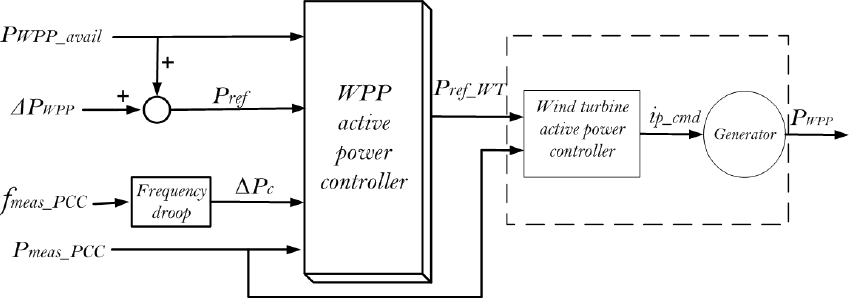
Figure 4. Aggregated WPP model.